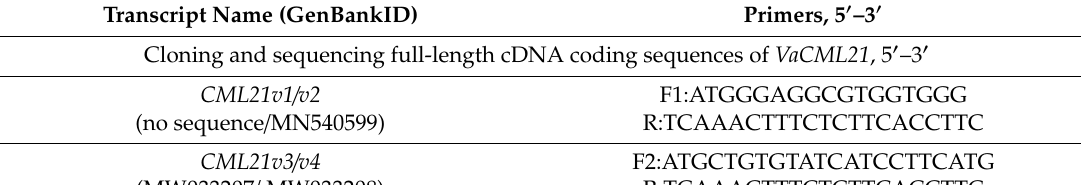
Table 2. Primers used for amplification of grapevine CML21 cDNAs and the house-keeping genes. Transcript Name